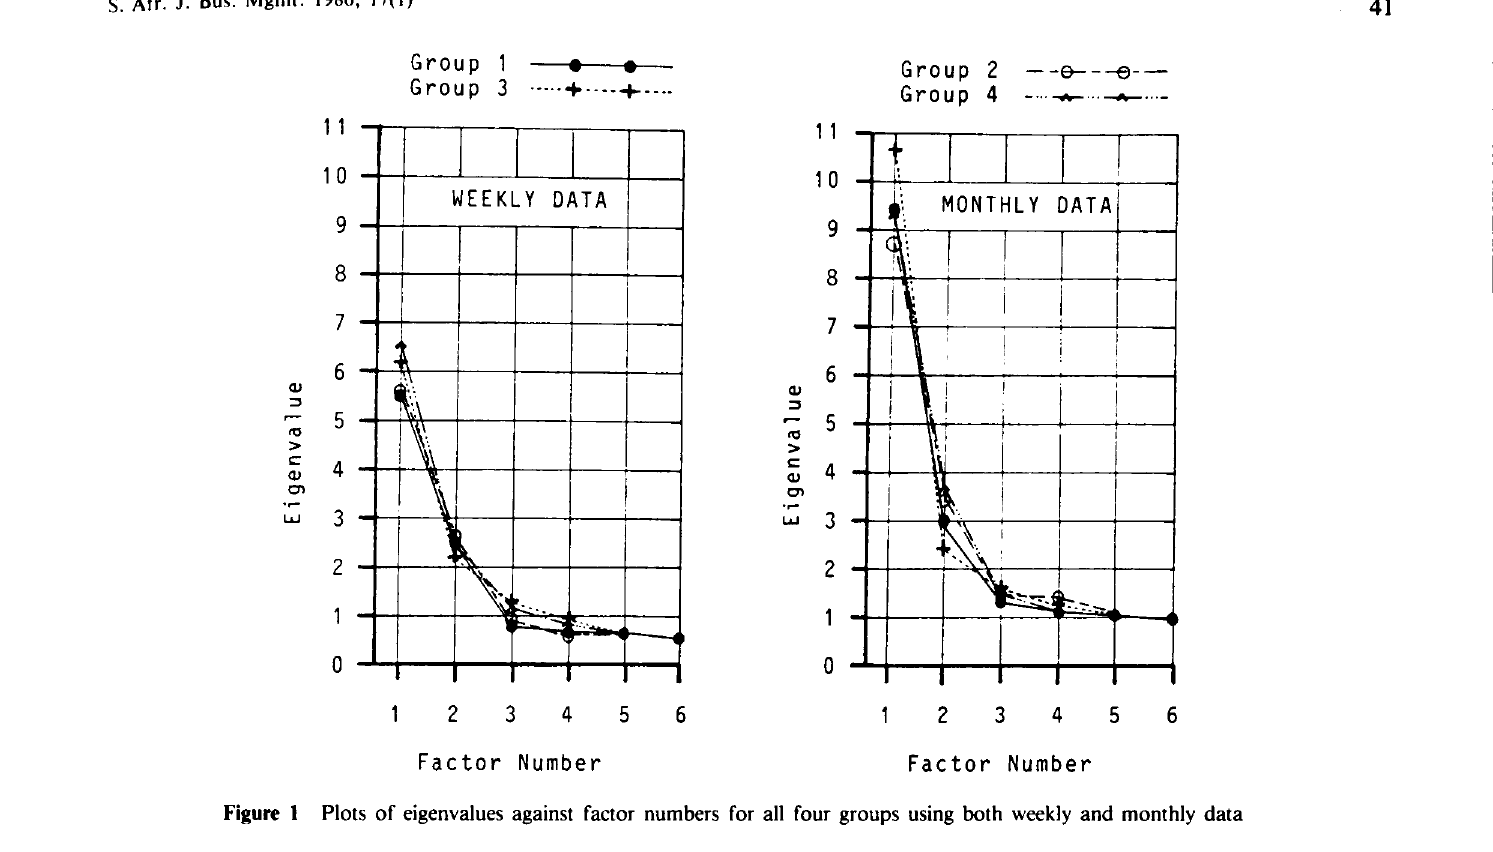
Market Model regression results